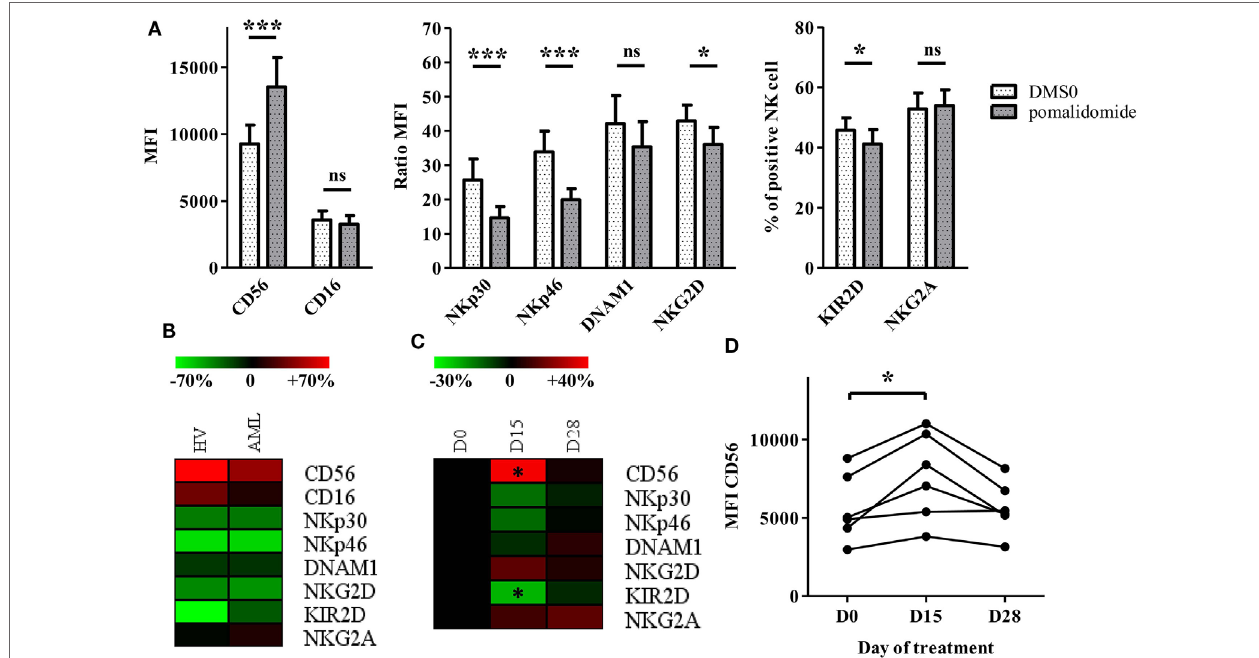
FigUre 4 | Immunomodulatory drugs induce natural killer (NK) cell phenotypic modifications in vitro and in vivo . (a) Purified NK from healthy volunteers (HV) ( n = 13) were pre-incubated for 48 h with pomalidomide (10 µM) or DMSO. Surface NK-cell receptors were expressed as mean fluorescence intensity (MFI), ratio MFI or percent of positive NK cells. Results were expressed as mean ± SEM and statistical significance was established using Wilcoxon matched pairs test. (B) PBMCs from HV ( n = 7) or acute myeloid leukemia (AML) patients ( n = 5) were incubated with pomalidomide or DMSO. Surface NK-cell receptors in the pomalidomide condition were presented as the relative variation range from − 70% (green) to + 70% (red) relatively to the DMSO condition. (c,D) PBMCs from patients with myeloid malignancies treated with lenalidomide ( n = 6) were analyzed by flow cytometry at day0 (D0), D15, and D28 for surface NK-cell receptors expression. Results were presented as the relative variation range from − 30% to + 40% relatively to D0 (c) . MFI for CD56 (D) . Statistical significance was established using Wilcoxon matched pairs test between D0 and